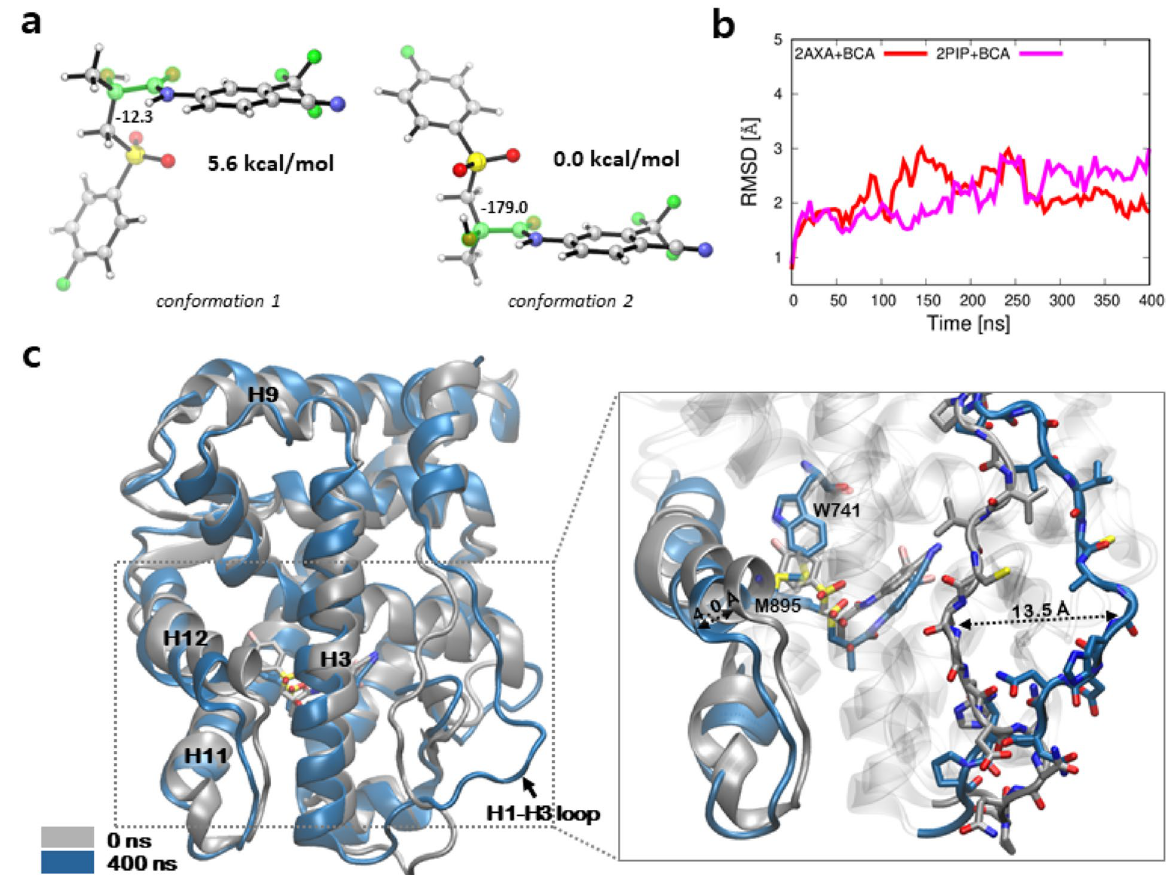
Figure 9. Comparison of conformational changes of the wild type AR bound to BCA. ( a ) Two conformers of BCA with the lowest energy; Left: conformation 1 with the second lowest energy; Right: conformation 2 with the lowest in energy conformation. The dihedral angles of the four highlighted atoms (O-C-C-O) are shown. Images were created by using CYLView v.1.0.561 56 . ( b ) The backbone RMSDs of aMD simulations relative to the initial conformation. Gnuplot v5.2 57 . ( c ) Comparison of the wild type ARs bound to BCA in conformation 2 at the initial (silver) and simulated structure after 400 ns (blue).Images were created by using VMD v1.9.3 52 AR (PDB code: 2AXA), so as to remove the translation-rotational motions of the protein. We then calculated the projection of each aMD trajectory to the computed PCs, as shown in Fig. 10a. WT AR bound to ENZ showed